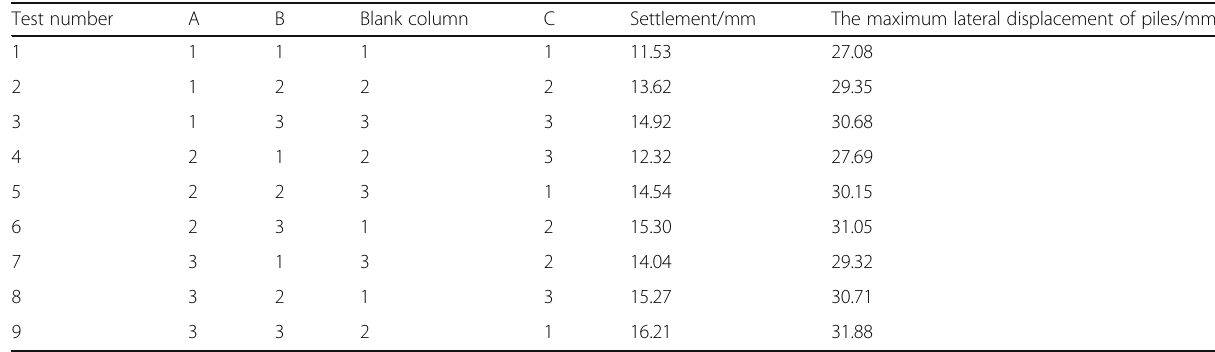
Table 7 Results of test